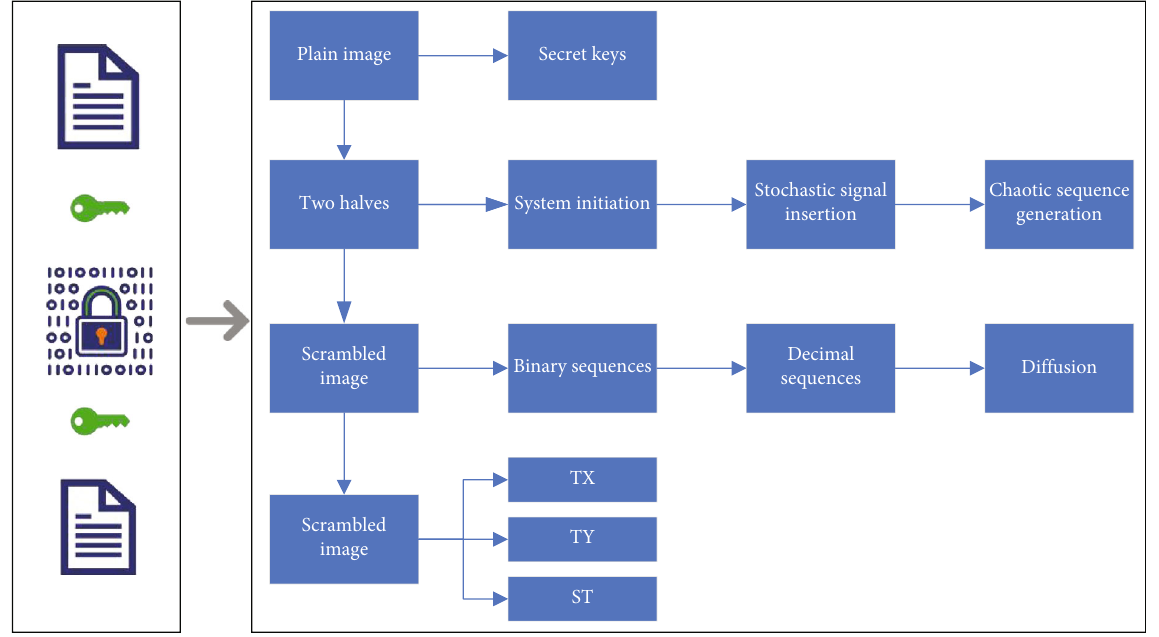
Figure 3: Image encryption system with plaintext